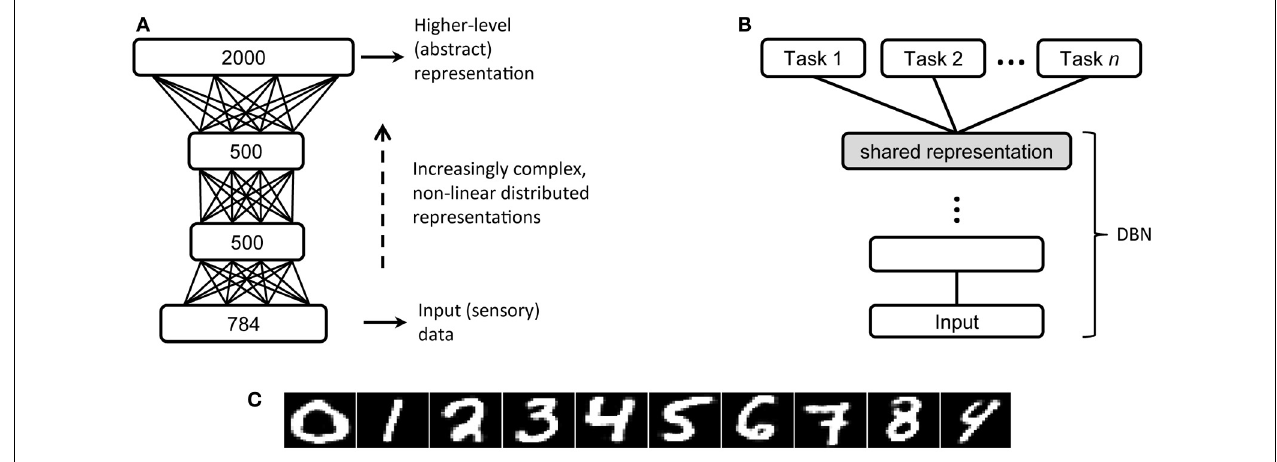
FIGURE 3 | (A) Architecture of the DBN with three hidden layers used in the MNIST handwritten digit recognition problem (Hinton and Salakhutdinov, 2006). (B) A typical transfer learning scenario, on which high-level, abstract representations are first extracted